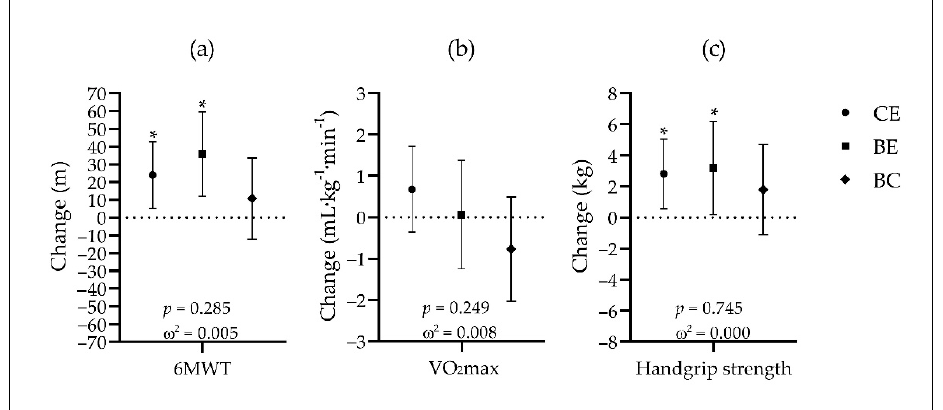
15 of 23 Table 7. Physical performance variables compared among groups over time. Data expressed as least squares mean ± SEM.